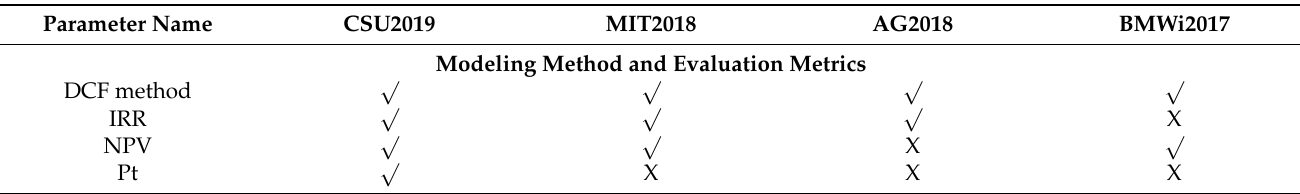
Table 5. Financial model method and tax consideration. IRR, internal rate of return; NPV, net present value. AG, African